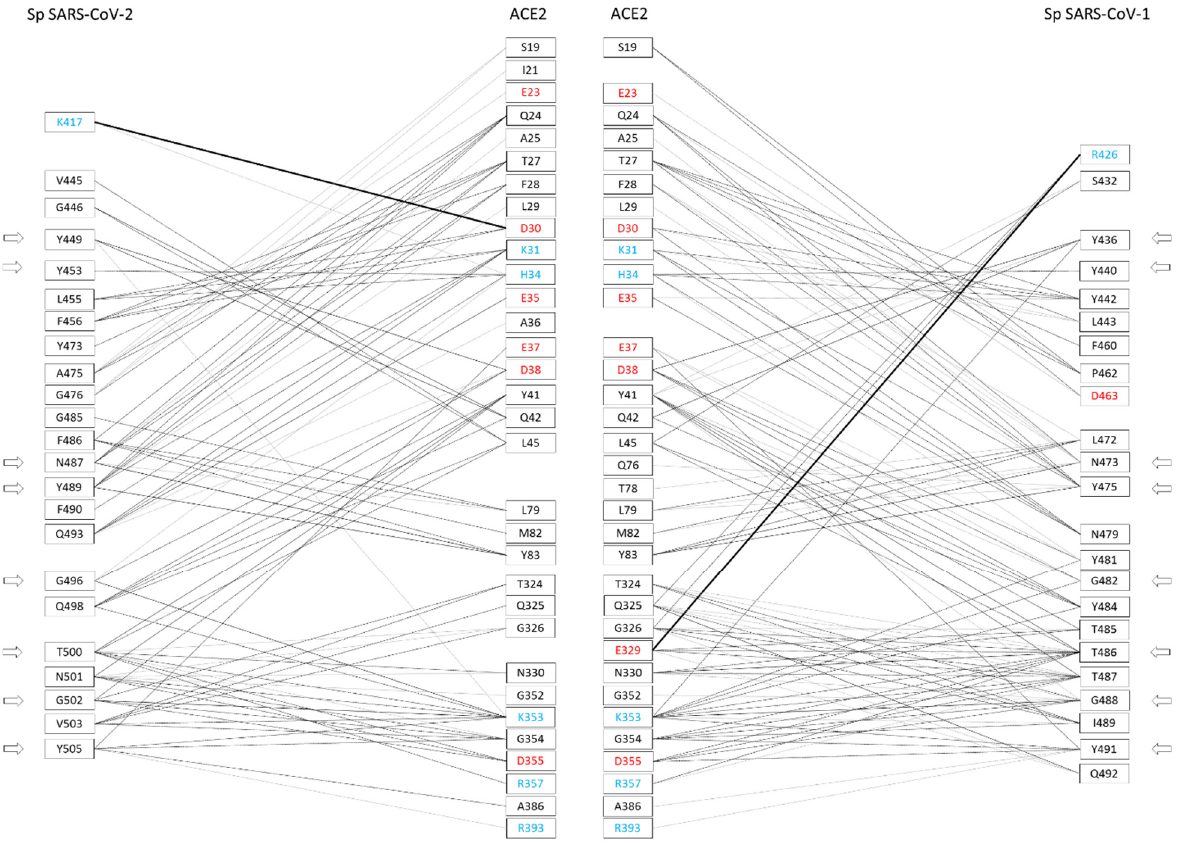
Figure 2. Amino acid residues of the spikes of CoV-2 and CoV-1 interacting with hACE2 at the binding interface, and vice versa (adapted from Giordano et al. 2021 [37]). The amino acids are color-coded: red = negatively charged residues; cyan = positively charged residues. The side arrows indicate the relative positions of the eight amino acid residues conserved to CoV-2 and CoV-1 spikes. The network of interactions between hACE2 and CoV-2/CoV-1 spikes (presented side-by-side) is restricted to H-bond and generic interactions (thin lines) and salt-bridges (large lines).